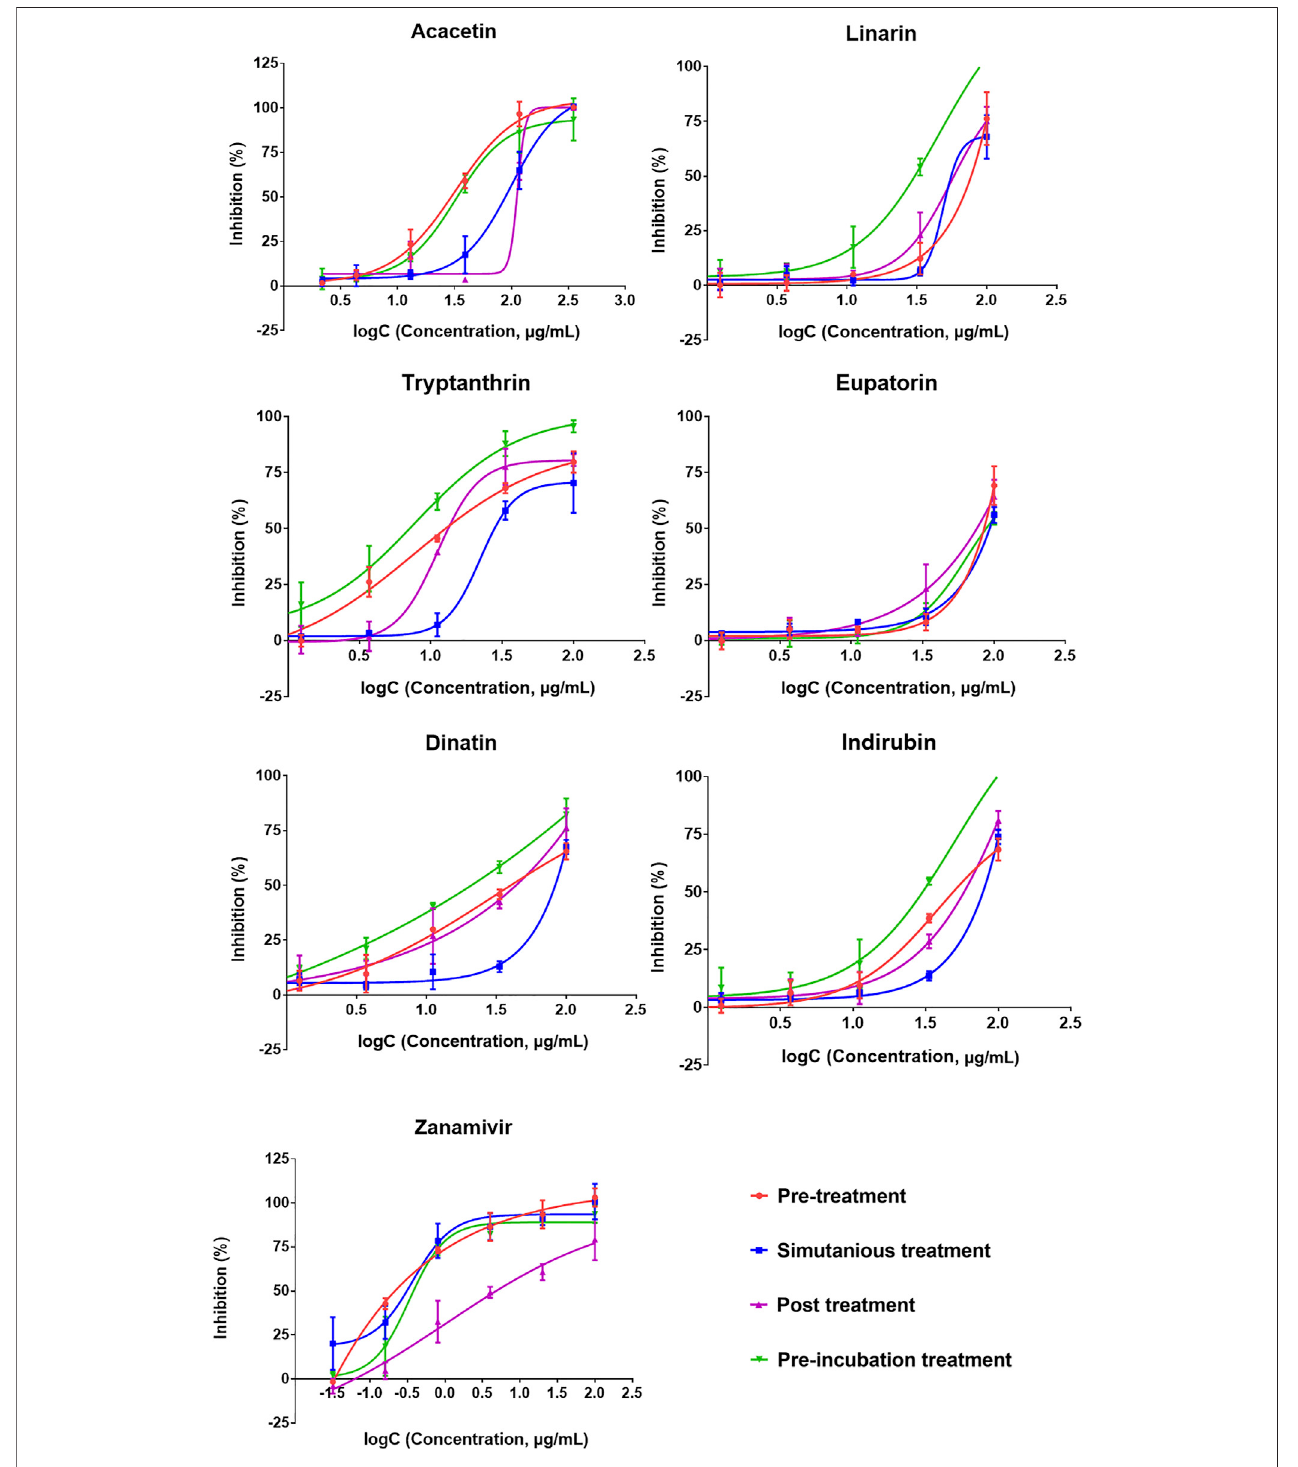
FIGURE 6 | Cytopathic effect (CPE) reduction assay results of the six predicted compounds (eupatorin, dinatin, linarin, tryptanthrin, indirubin, and acacetin) and positive control drug (zanamivir) toward the oseltamivir- and amantadine-resistant H1N1. The 50% effective concentration (IC 50 ) values are provided in Table 4 .